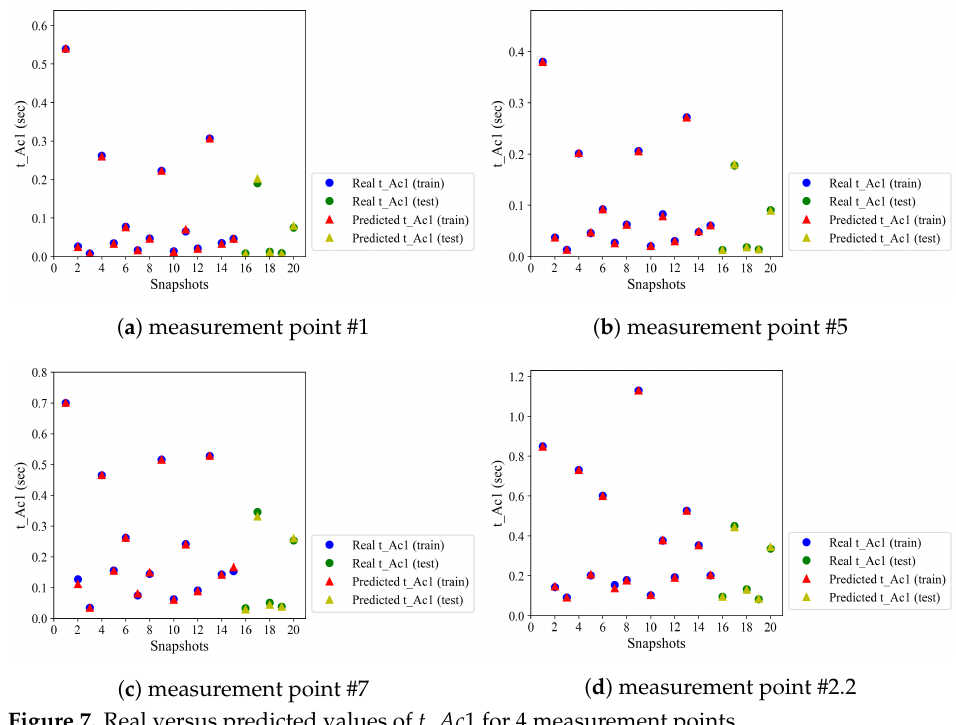
Figure 7. Real versus predicted values of t _ Ac 1 for 4 measurement